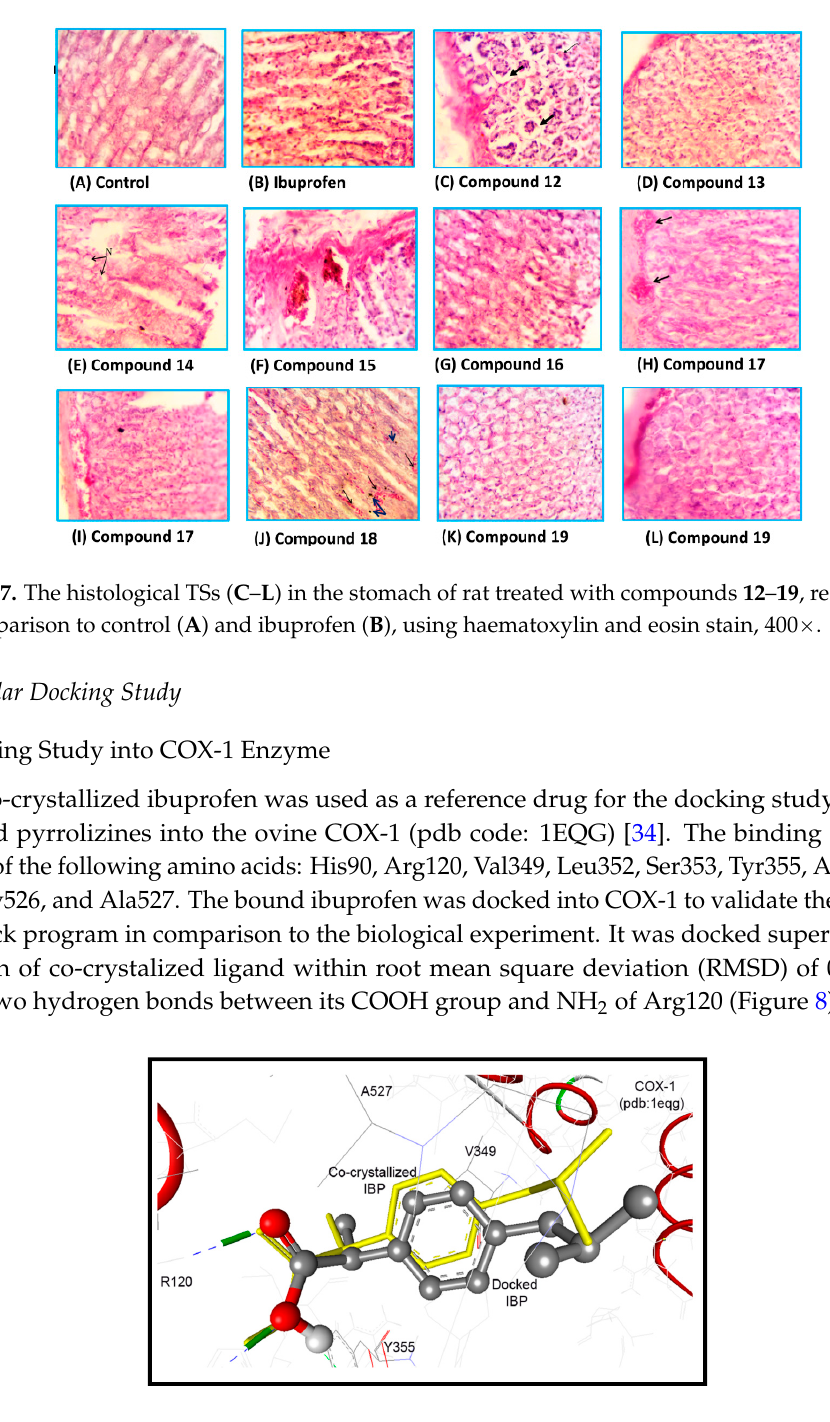
Figure 8. Ibuprofen docked superimposed onto the position of co-crystalized ligand within RMSD of 0.62 Å, and exhibited two hydrogen bonds between its COOH group and NH 2 of